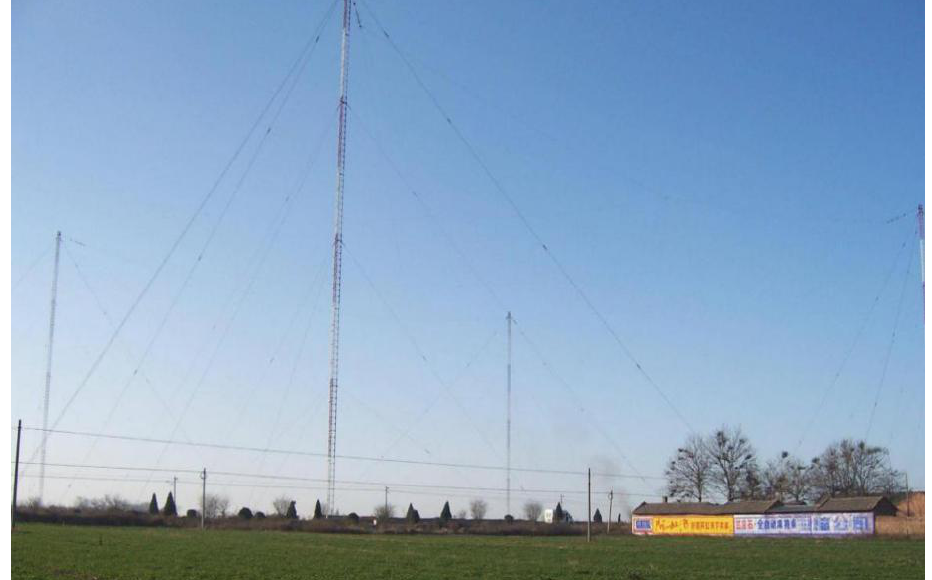
Figure 1. Four towers of the BPL antenna.